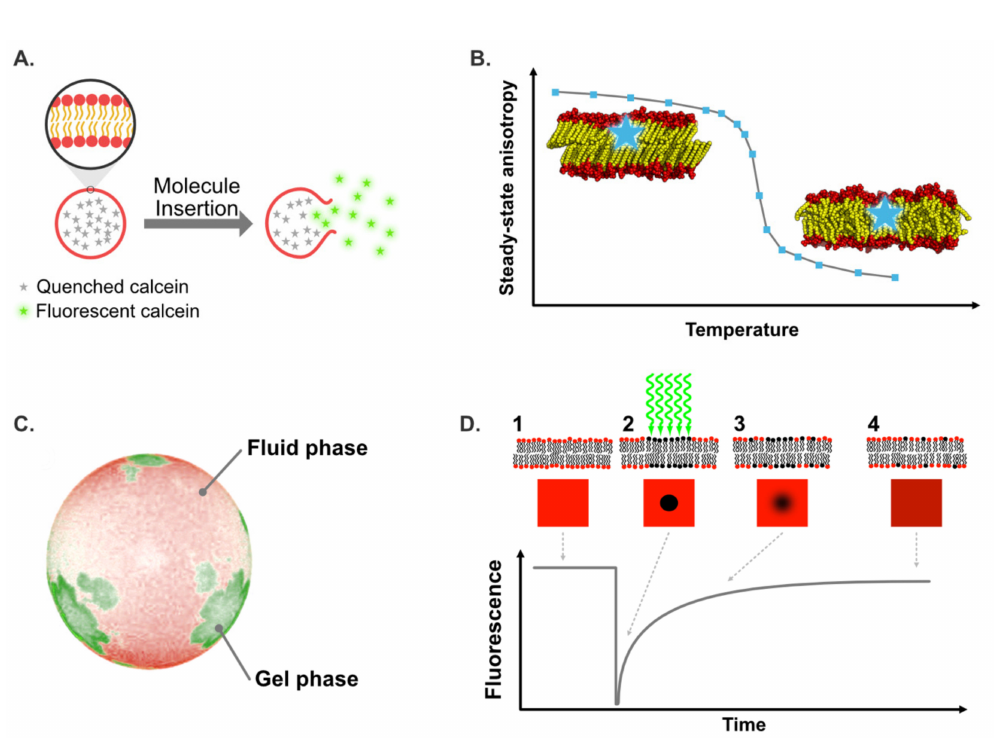
Figure 6. Di ff erent fluorescence approaches used for the study of bioactive molecule / membrane interactions. (Panel A ) depicts a calcein release experiment where the membrane-active molecule is added to a solution of liposomes filled with a solution of calcein at a concentration high enough to be quenched (no fluorescence). If the added molecule destabilizes the lipid membrane, the calcein will be released outside of the liposome and its concentration will decrease enough that the probe will fluoresce. (Panel B ) shows how the decrease of the steady-state anisotropy (see text for details) when the temperature rises can be used to characterize phase transition. (Panel C ) shows DOPC / DPPC liposomes doped with two fluorescent probes: DOPE-Rho (red) and DPPE-NBD (green). As these probes are segregated to the fluid phase (for DOPE-Rho) and gel phase (for DPPE-NBD), they can be used to visualize and distinguish these phases. (Panel D ) illustrates the di ff erent step of a fluorescence recovery after photobleaching (FRAP) experiment: (1) fluorescent lipid membrane at equilibrium (maximum and steady fluorescence), (2) fluorescent lipids are locally photobleached by a light pulse, (3) as the lipid di ff usion occurs, the photobleached lipids and fluorescent lipids are mixed and the bleached area blurs out until (4) the fluorescence becomes uniform